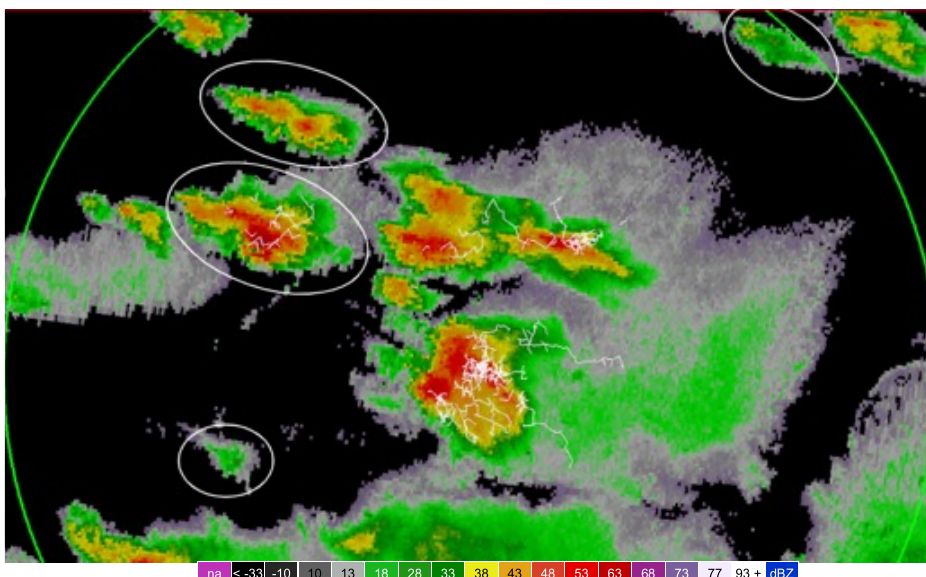
Figure 1. Composite reflectivity with 3D lightning channels overlaid in WDSS − II at 2153 UTC 21 June 2016. Examples of isolated cells are highlighted with white circles.